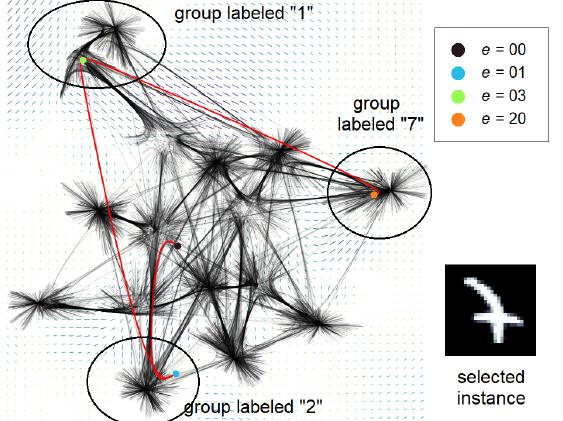
Figure 7. A single outlier trajectory is selected for examination. This data point was at the middle area at epoch 0, moved to an area containing many examples labeled as “2” at epoch 1, moved again to an area containing examples labeled “1” at epoch 3, and finally moved to another area, which contains a group of examples labeled “7”, at epoch 20. We can then examine the instance to search for reasons behind this atypical